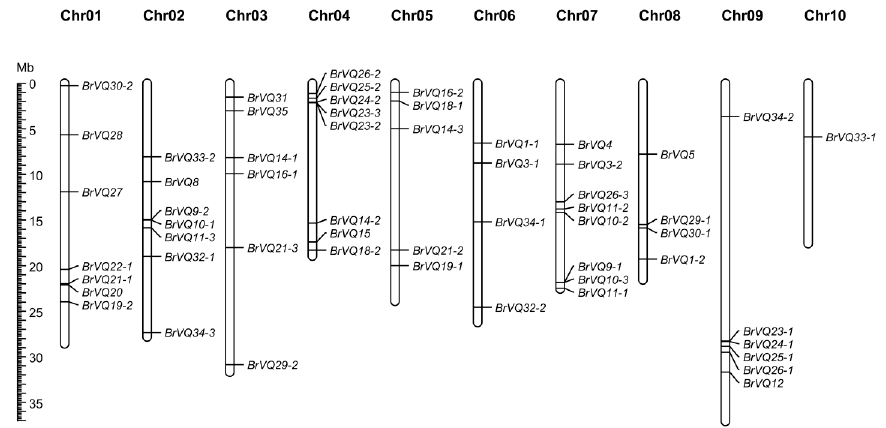
Figure 5. The distribution of the VQ genes of Chinese cabbage on 10 chromosomes. The chromosome number is indicated at the top of each chromosome. BrVQ gene numbers are shown on the right of each chromosome. Table 2. Syntenic VQ genes between Arabidopsis and Chinese cabbage.